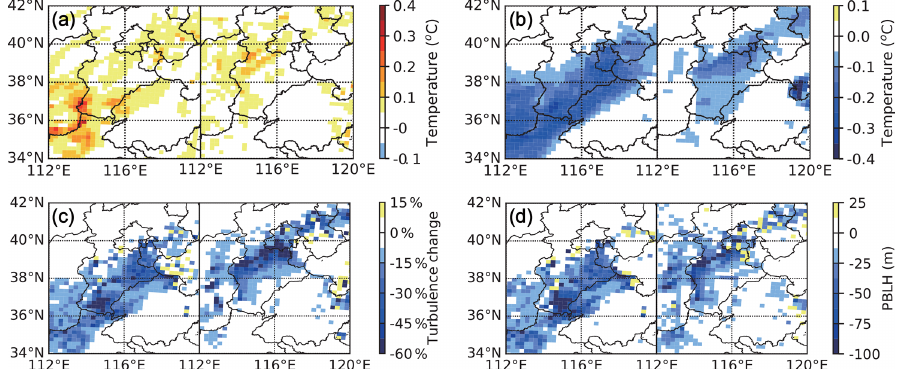
Figure 8. Influence of upper level dust on meteorology parameters in HPI 1 and HPI 2 dissipation stages. (a) Maximum enhancement in temperature above the PBL. (b) Maximum temperature reduction within the PBL. Difference in (c) turbulence within the PBL and (d) PBL height between the experiments dust_on and dust_off. The time of each subgraph is the HPI 1 dissipation stage at 13:00LT on 26 January 2017 (left panels) and HPI 2 dissipation stage at 16:00LT on 4 February 2017 (right